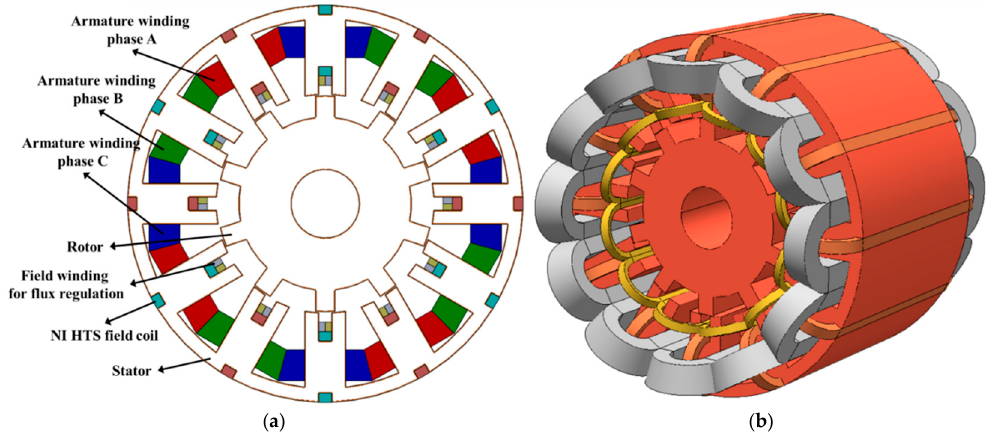
Figure 3. Topology of the flux-controllable flux-switching machine (FSM): ( a ) cross section, and ( b ) three-dimensional configuration.